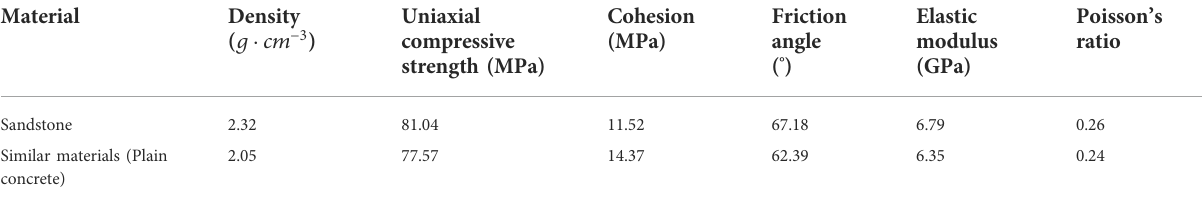
TABLE 1 Mechanical parameters of sandstone and similar materials (Qu, 2018).